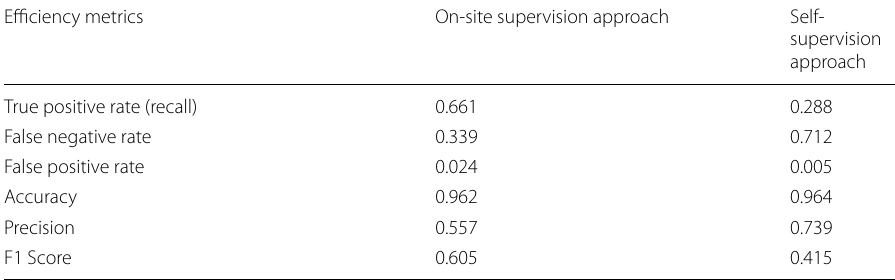
Table 8 Performance comparison—on-site supervision and self-supervision